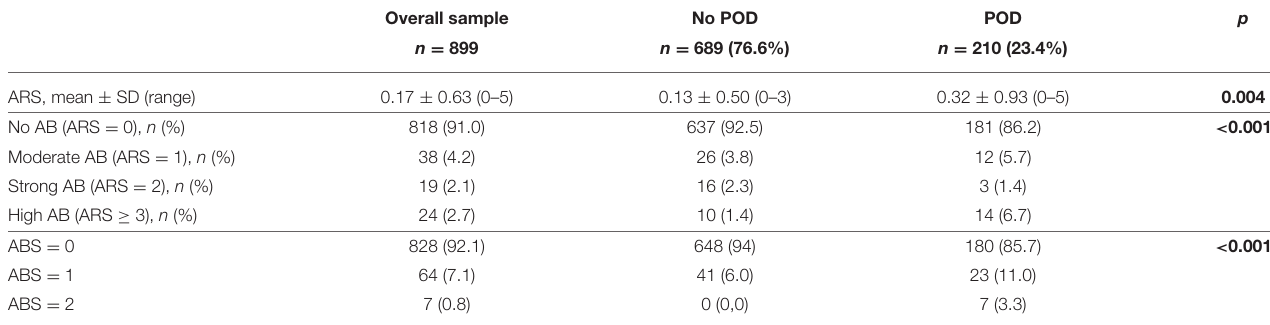
TABLE 2 | Characteristics of anticholinergic burden according to ARS and ABS in patients with and without postoperative delirium. Overall